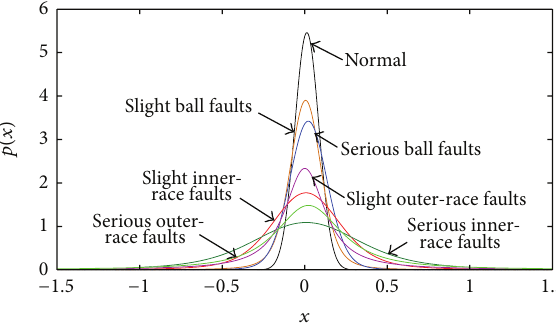
Figure 7: Probability Density